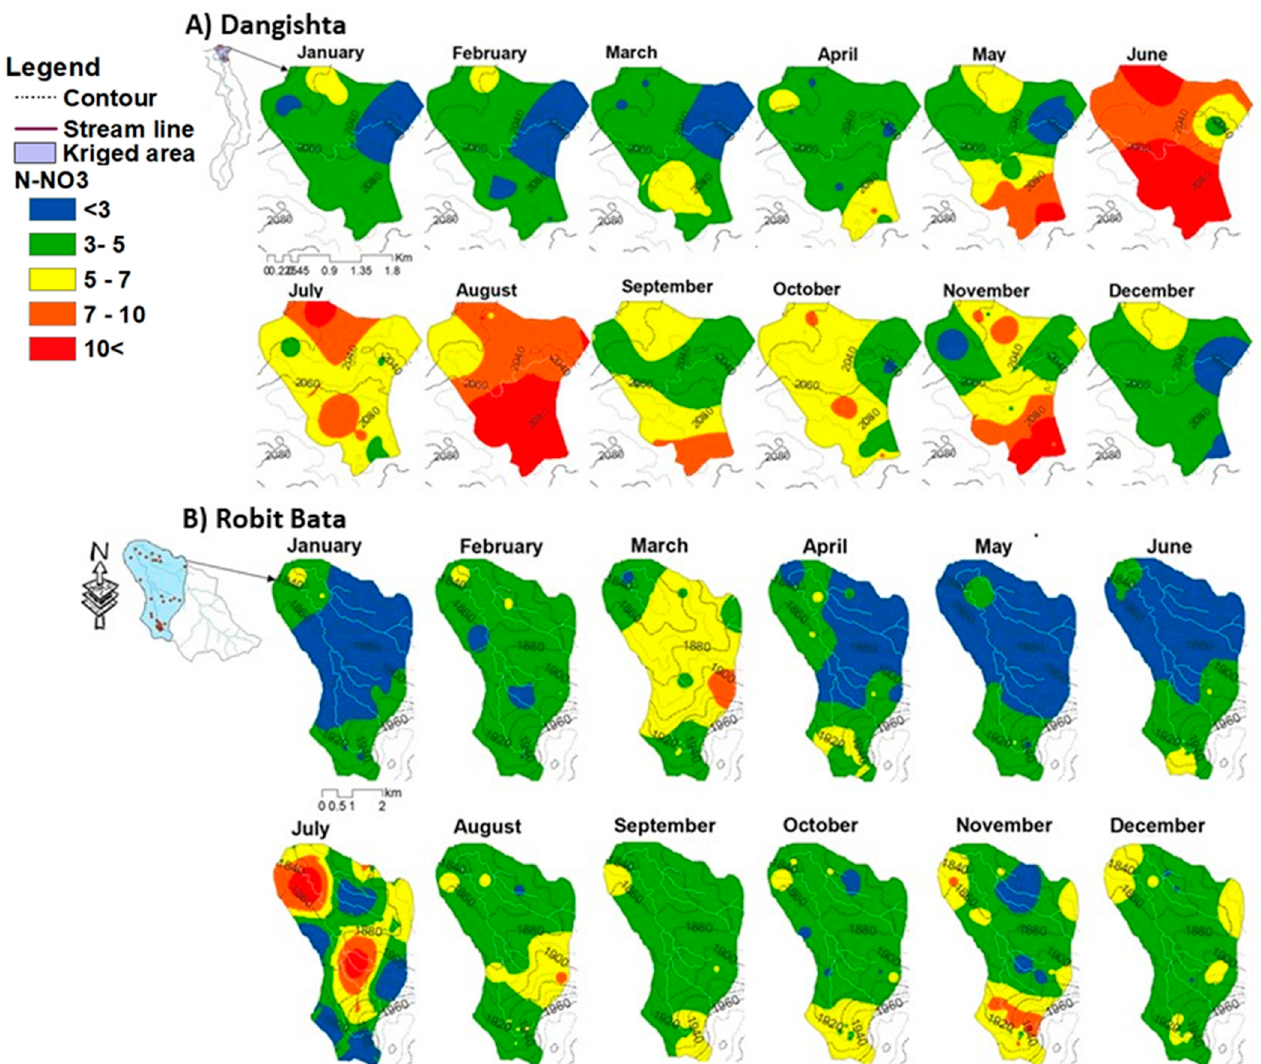
Figure 8. Monthly, two-year-averaged kriged nitrate concentration (2017 to 2018) in mg N-NO 3 − L − 1 in the aquifers of ( A ) Dangishta and ( B ) Robit Bata watersheds.